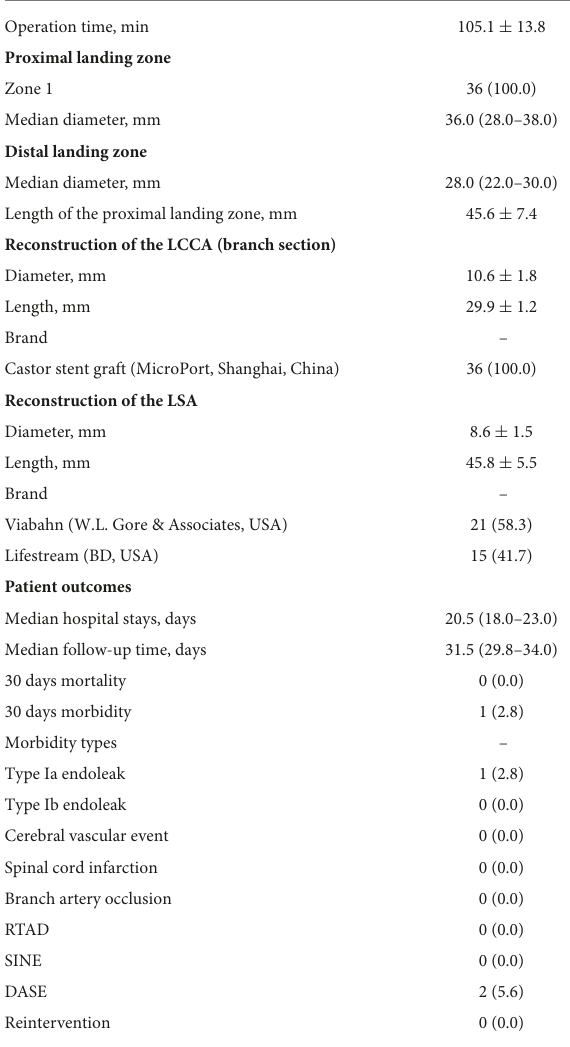
TABLE 3 Operative procedures and outcomes of 36 patients treated by thoracic endovascular repair (TEVAR) for primary retrograde type A aortic